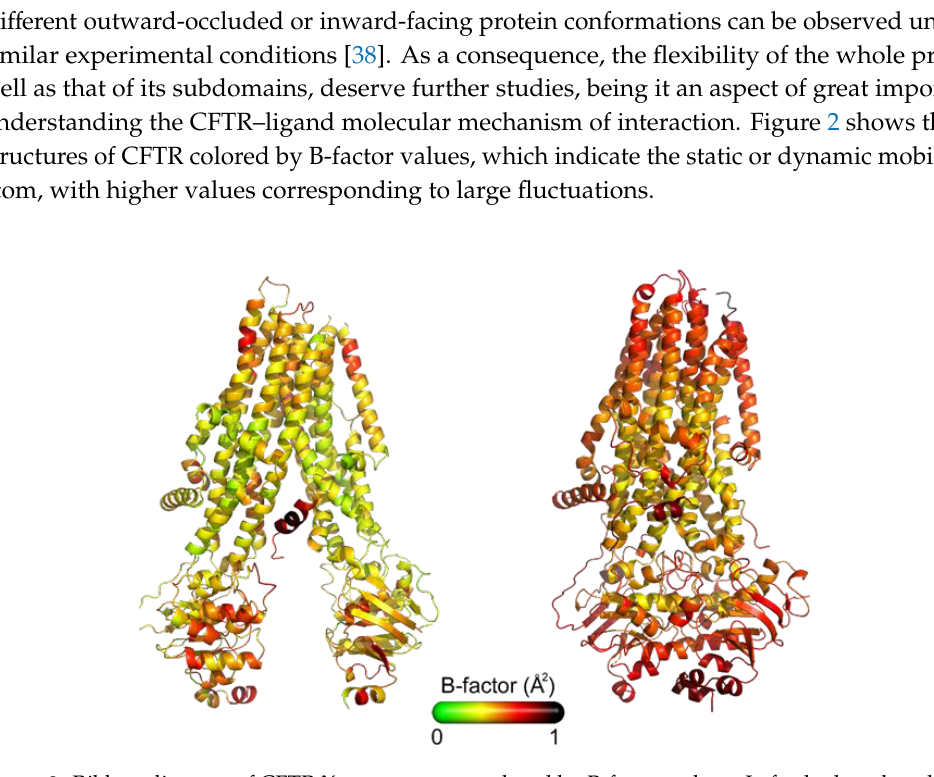
Figure 2. Ribbon diagram of CFTR X ray structures colored by B-factor values. Left: dephosphorylated CFTR wild type without ATP bound (PDB code 5UAK), right: phosphorylated CFTR (1 stabilizing mutation) with ATP bound (PDB code 6MSM). The color scale date range is shown below, the high and low values of CFTR mobility are in red and green respectively.